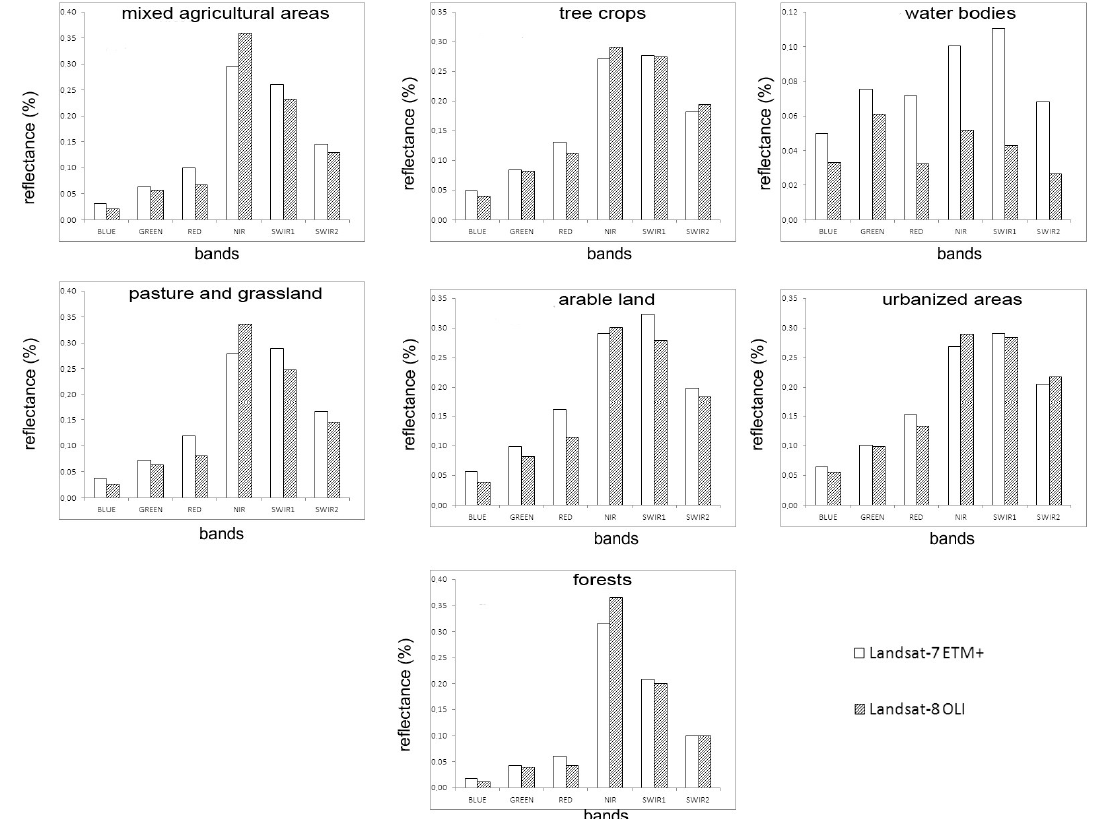
Figure 3. OLI and ETM+ bands reflectance values for land use classes. Table 5. Summary Statistics for the vegetation indices calculated from the ETM + and OLI sensors